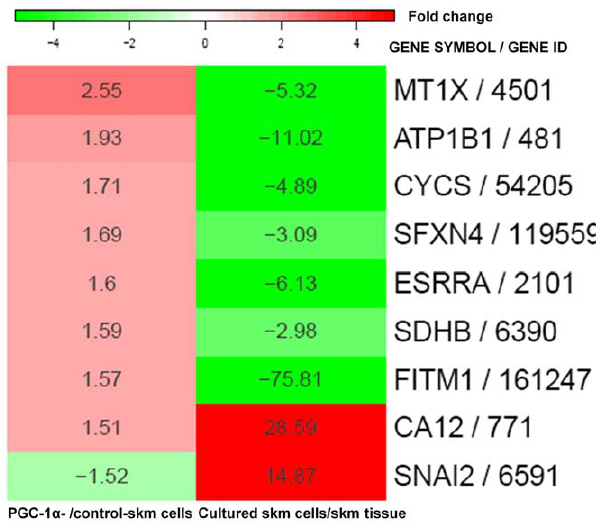
Figure 2. Genes regulated by both PGC-1 a -overexpression in cultured skm cells and skm cultures in comparison to skm tissue. Heat map including the genes (Gene symbol/Gene ID for Entrez Gene) in Table 1 (PGC-1 a - versus control-skm cells) that were also found to be differentially expressed after human skm culture according to Table S2 from [25] (cultured skm cells versus skm tissue). Each cell displays the absolute fold change in the corresponding comparison and is filled according to the color gradient shown at the top (green and red for down and upregulated genes, respectively).